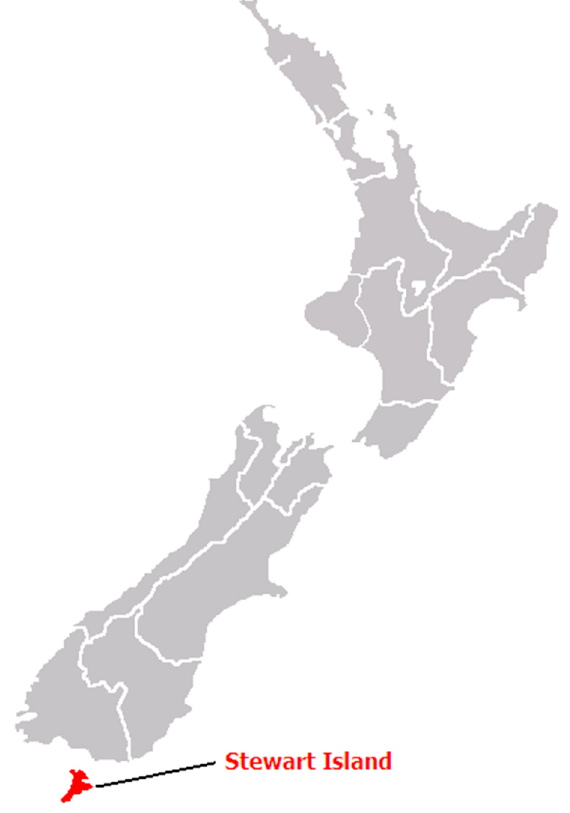
Figure 2. Location of Stewart Island.